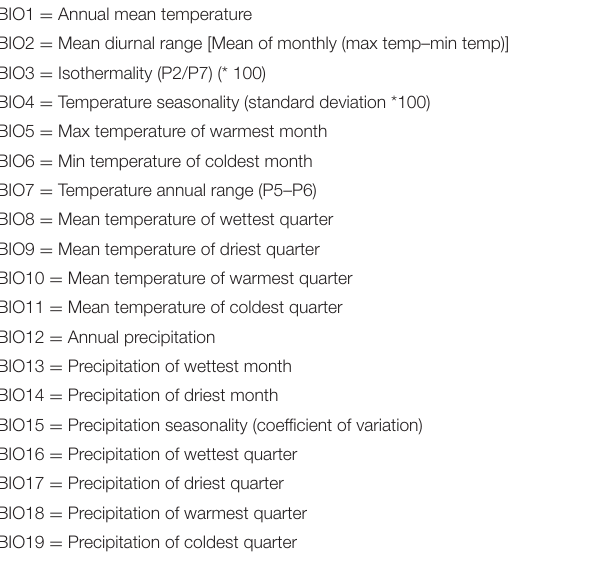
TABLE 2 | A list of bioclimatic variables used to build ecological niche models of rodent-borne cestodes in Gauteng Province, South Africa. BIO1 = Annual mean